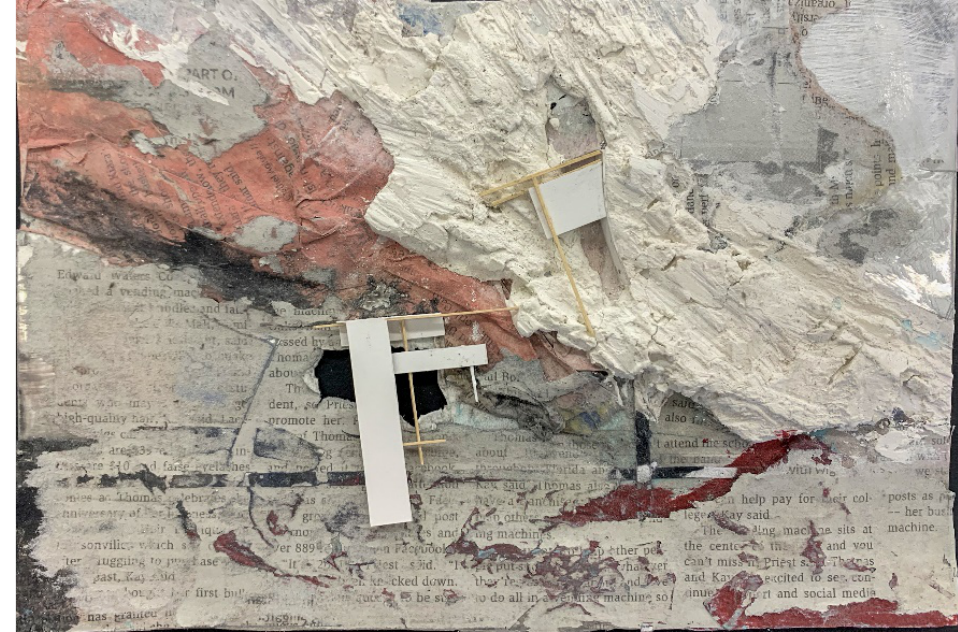
Figure 2. Design Studio Work by Tatiana Campos for Elizabeth Cronin’s Class (Campos 2021).